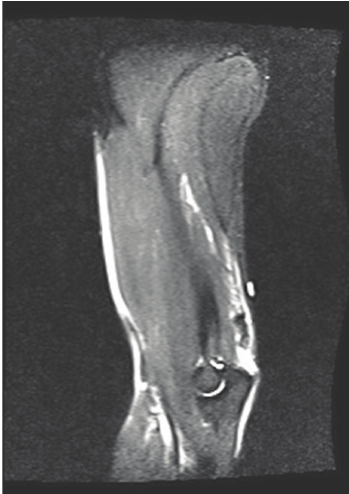
Figure 1: Left elbow, avulsion fracture through an enthesophyte at the distal triceps insertion, with 2.6 cm of proximal retraction of the triceps tendon. The underlying triceps ligament is thickened and of abnormal signal consistent with triceps tendinopathy. Ulnar collateral ligament stripping injury o ff the sublime tubercle. The remaining ligaments of the elbow are intact.